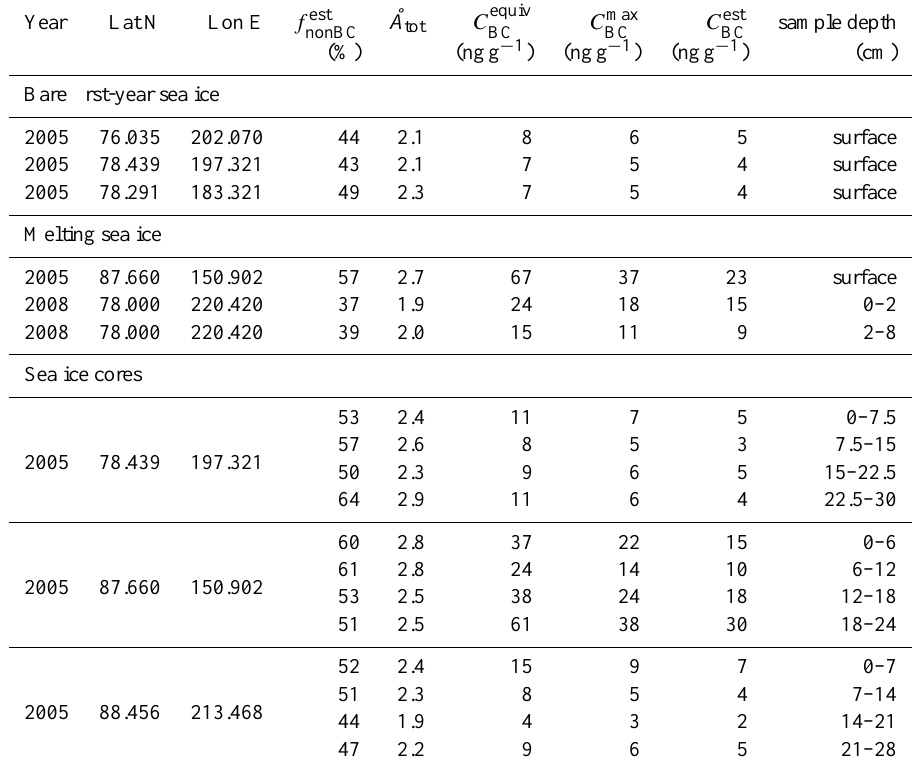
Table 4. Values for bare sea ice samples from the Arctic Ocean in summer. There is one sample per measurement shown. Year Lat N Lon E f est